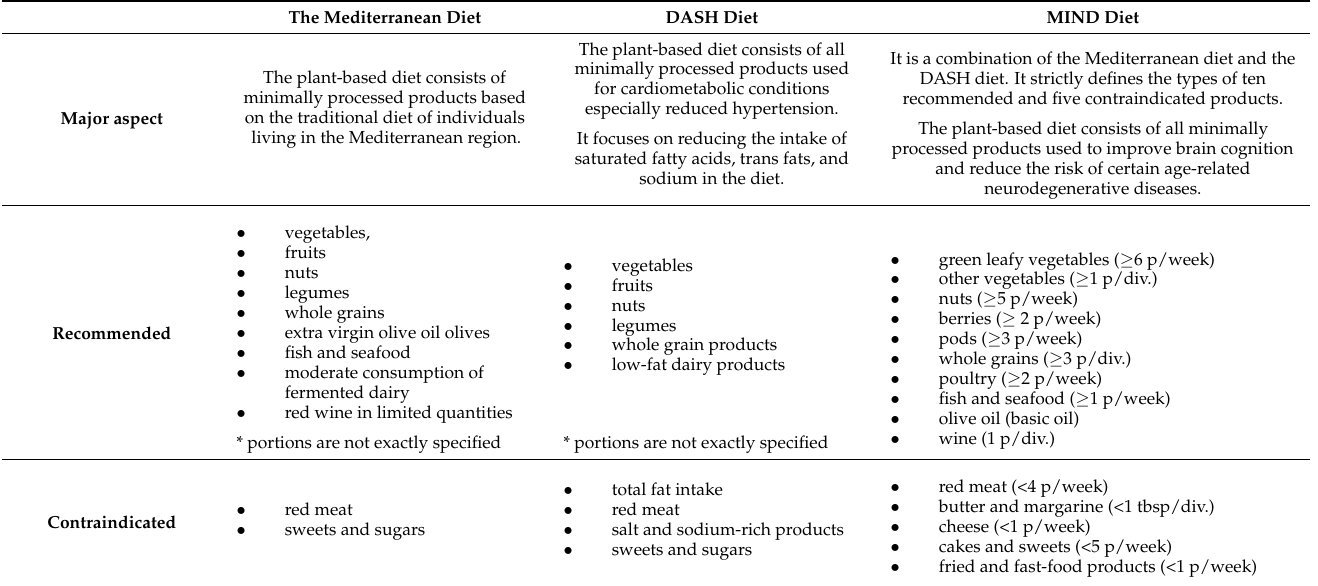
Table 1. Comparison of Mediterranean, DASH, and MIND diet—major aspect, recommended and contraindicated food products.